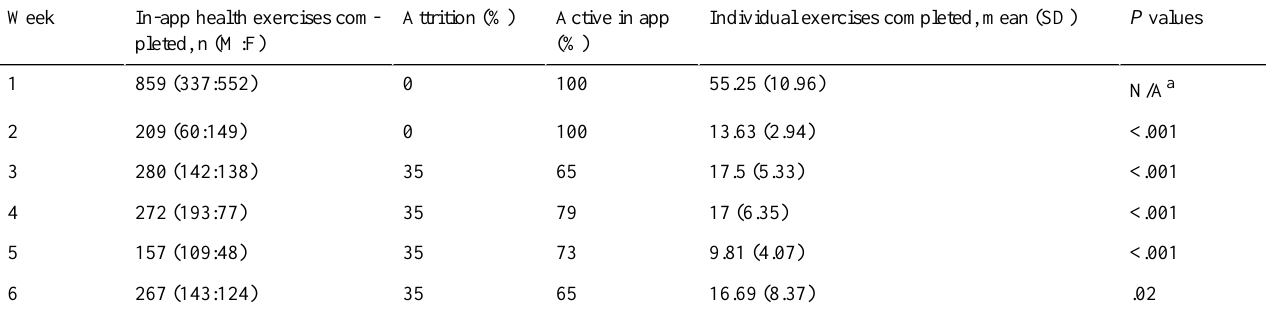
Table 2. Weekly comparison of usage and attrition.